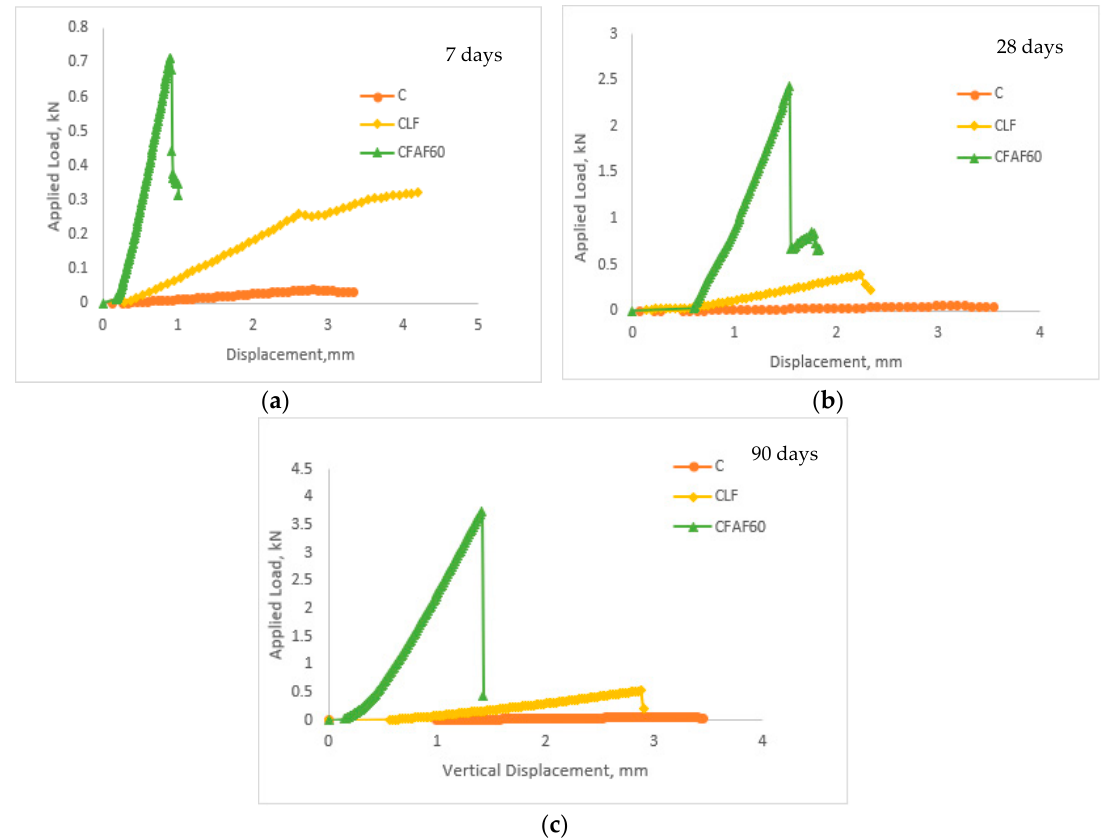
Figure 4. Load versus Displacement (Flexural) for ( a ) 7 days, ( b ) 28 days and ( c ) 90 days.